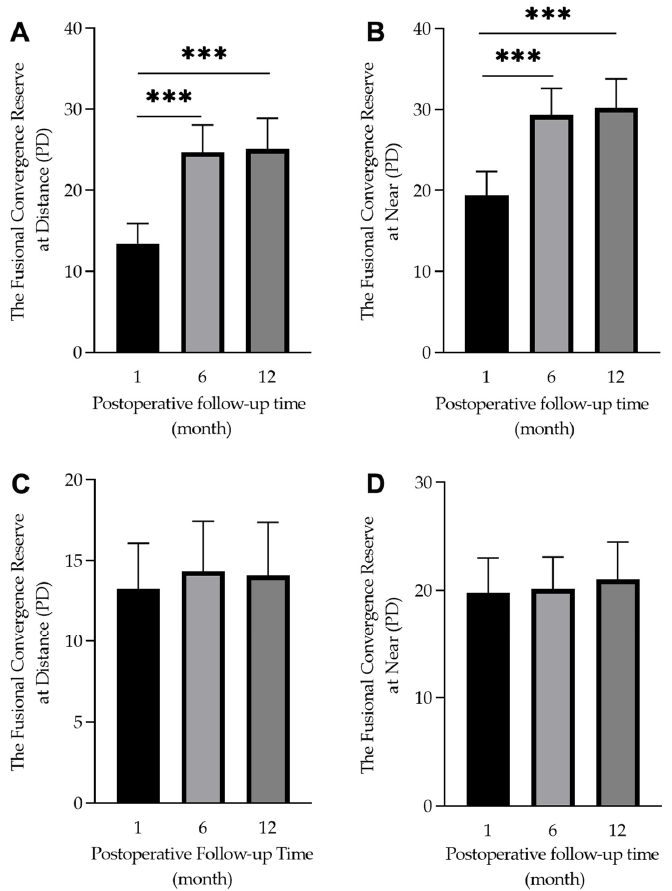
Figure 4. Box diagram showing the 1-, 6-, and 12-month postoperative fusional convergence reserve in the orthoptic therapy group ( A , B ) and the control group ( C , D ). There was a significant difference within the group (*** p < 0.001).